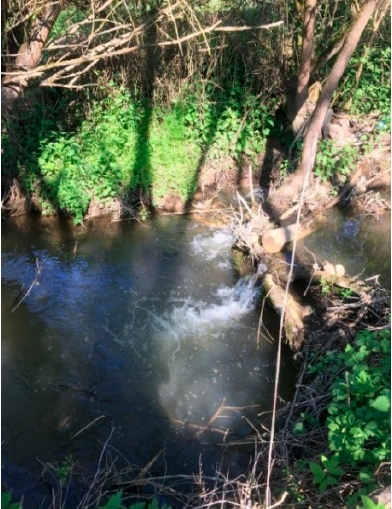
Figure 7. Valchid River refuge habitat.